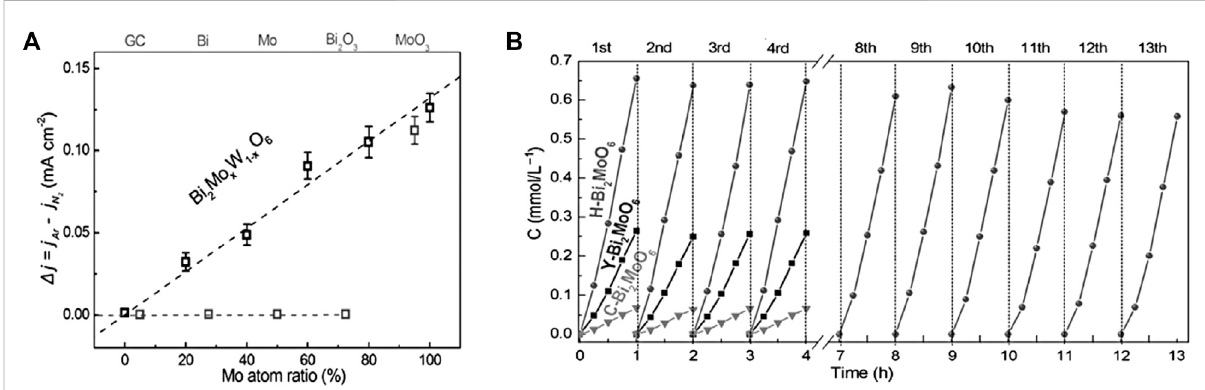
FIGURE 8 (A) The relative current densities ( Δ j = j Ar – j N2 ) measured at 0.6 V vs. saturated calomel electrode (SCE) of different samples. (B) Multicycle photocatalyticNH 3 generation fromairofdifferentsamples undersimulatedsunlightirradiation.Reproduced fromZhao etal.,2016 withpermission from the John Wiley and